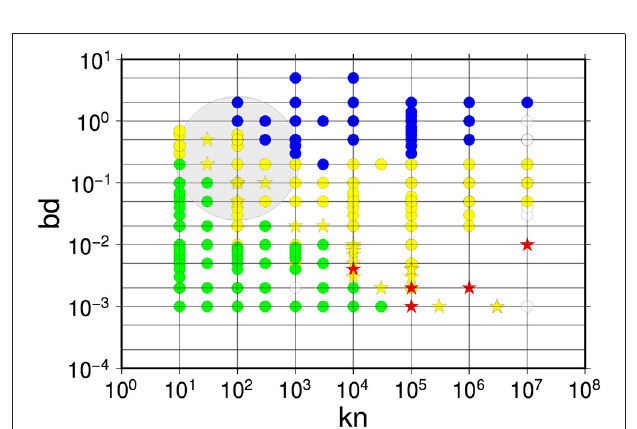
FIGURE 16 | The delay δ x = x c − x p between the critical stress x c and the strain at which the elastic energy absorption rate reaches maximum for all but ductile-like simulation results. The dashed curves show the FBM predictions for power law distributions with α = 0 and 5. The circled events show systematically underestimated δ x values due to used procedure of δ x calculation (see text for